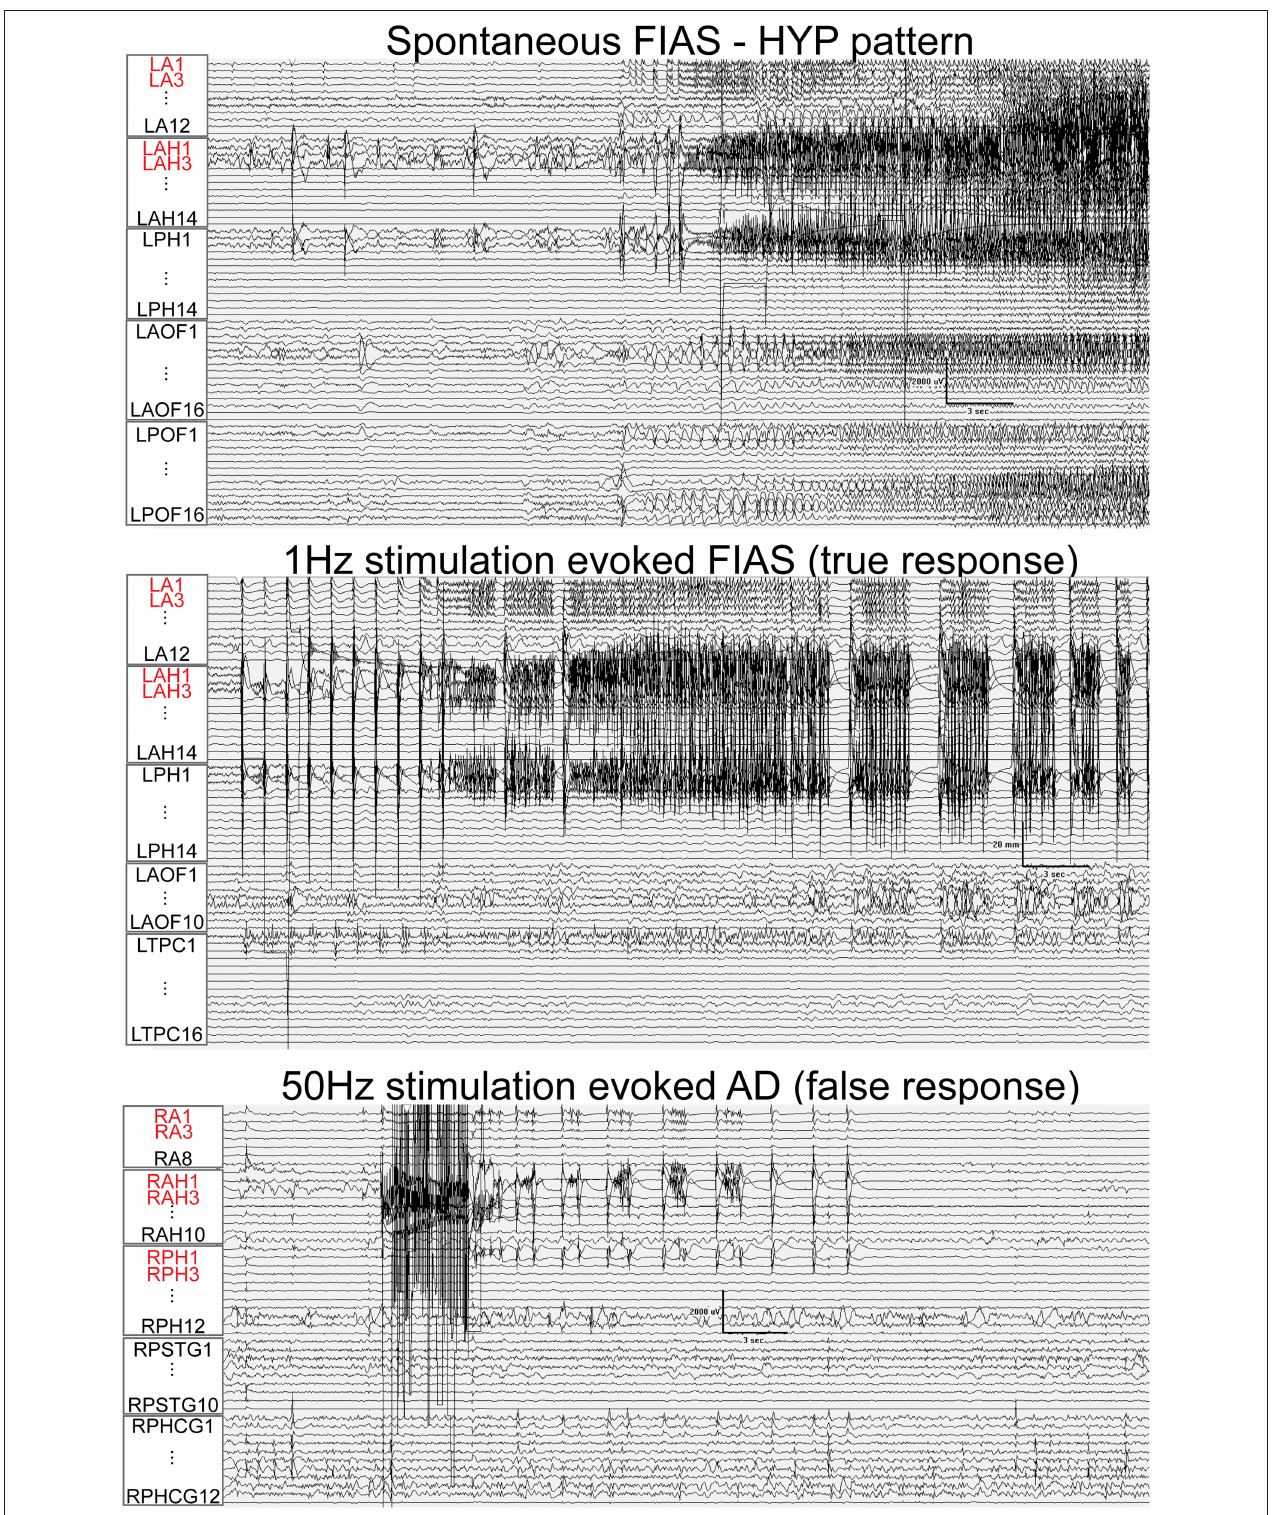
FIGURE 4 | Train of 1Hz and 50Hz stimulation of hippocampus evoked seizure (true response) and after-discharges (AD, false responses) in different patients that had hypersynchronous (HYP) electrographic onset pattern of spontaneous seizure. Nodes with a high epileptogenicity index ( > 0.3) are highlighted in red. HYP, hypersynchronous pattern; FIAS, focal impaired awareness